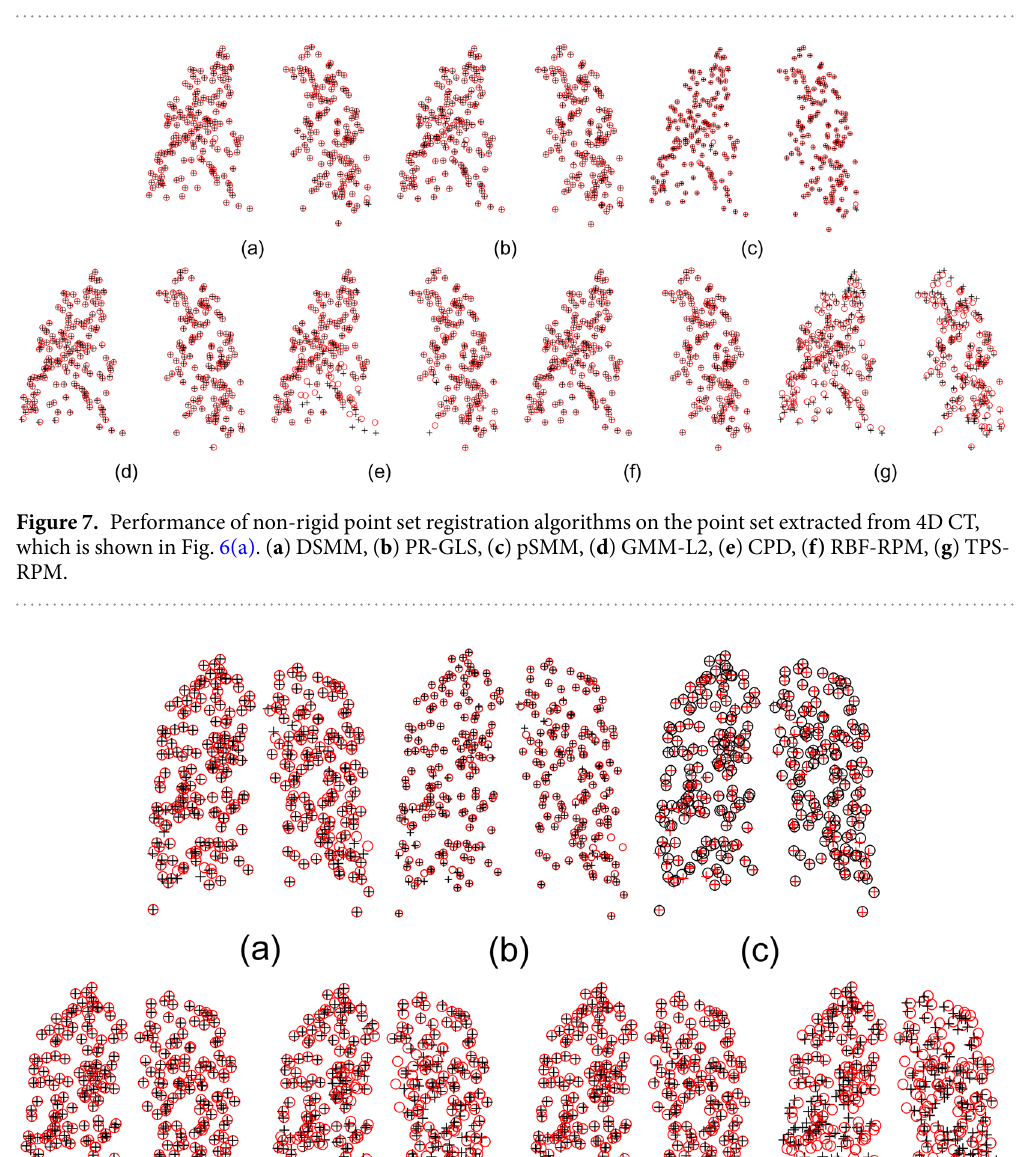
Table 2. Mean 3D Euclidean magnitude distance and standard deviation (unit: mm) for all subjects of 3D point sets before registration.